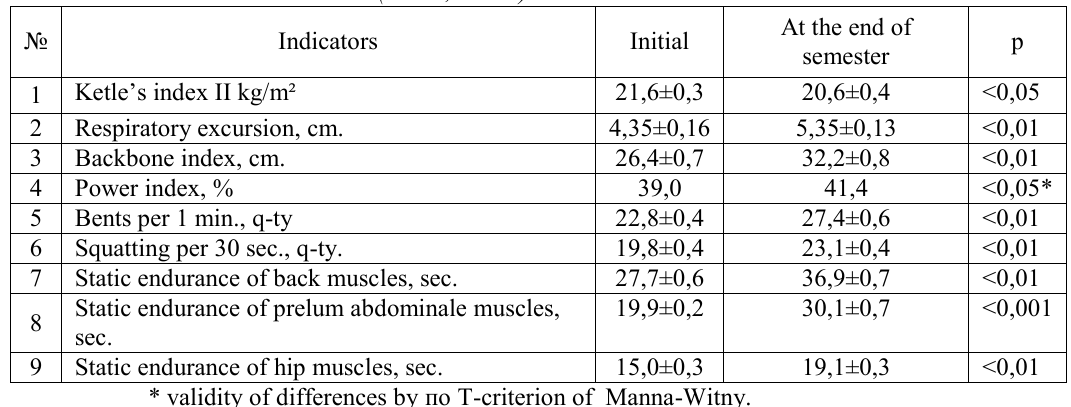
Indicators of special health group pupils’ physical